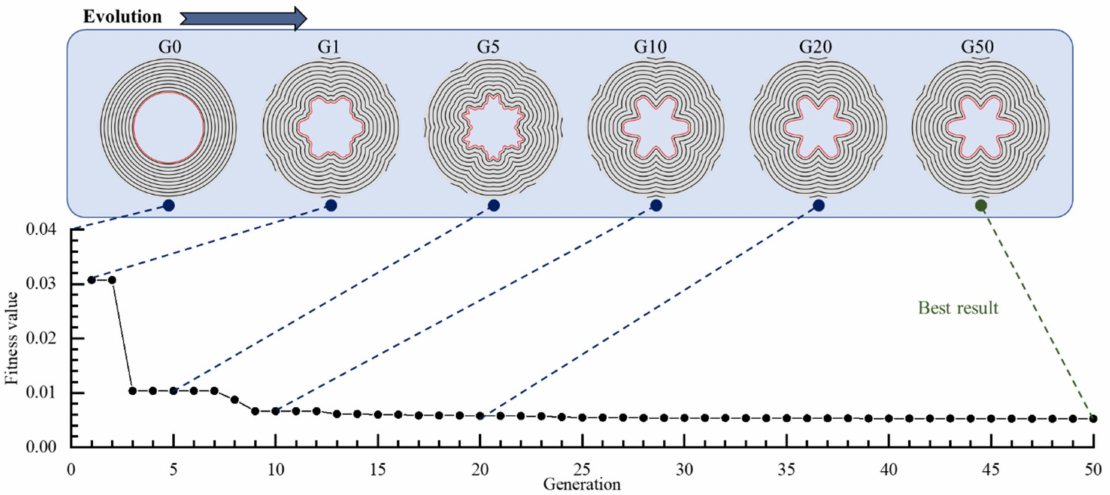
Figure 18. Evolution of the designed star